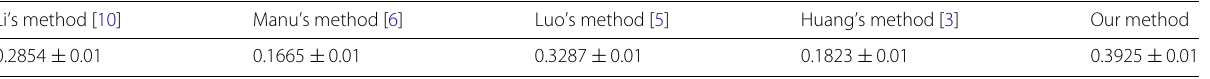
Table 2 Quantitative comparison of different methods on real rainy images Li’s method